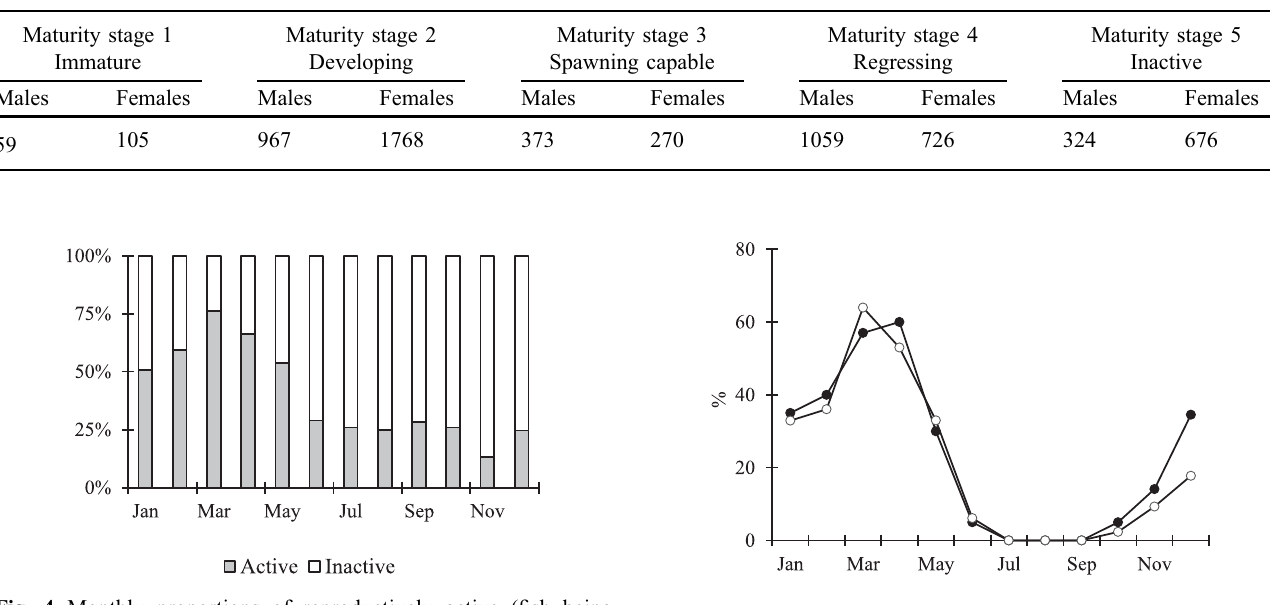
Table 3. Number of fi sh from the Portuguese coast sampled per maturity stage.